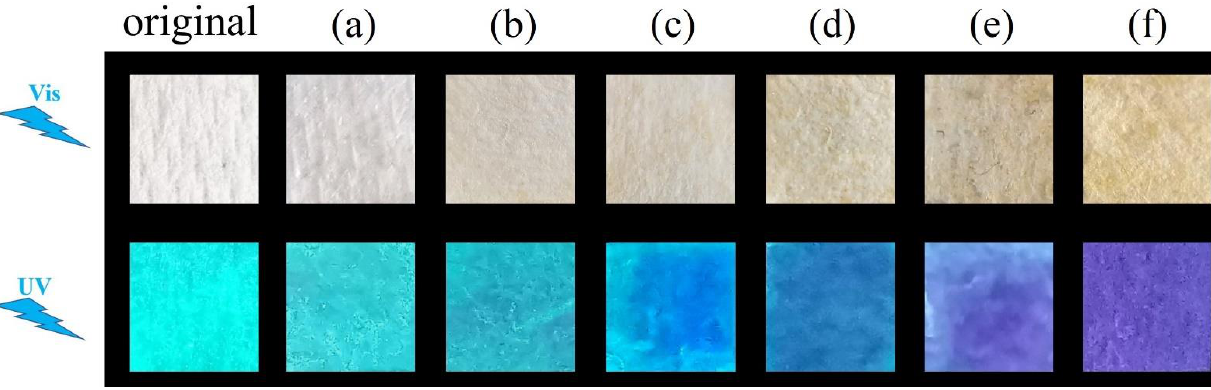
Figure 5. The naked-eye recognition matrix diagram of paper-based sensor TPE4A for different concentrations of ClO − under visible and UV light. Original 0 M, ( a ) 5.0 × 10 – 4 M, ( b ) 1.0 × 10 – 3 M, ( c ) 5.0 × 10 – 3 M, ( d ) 1.0 × 10 – 2 M, ( e ) 5.0 × 10 – 2 M, ( f ) 1.0 × 10 – 1 M.